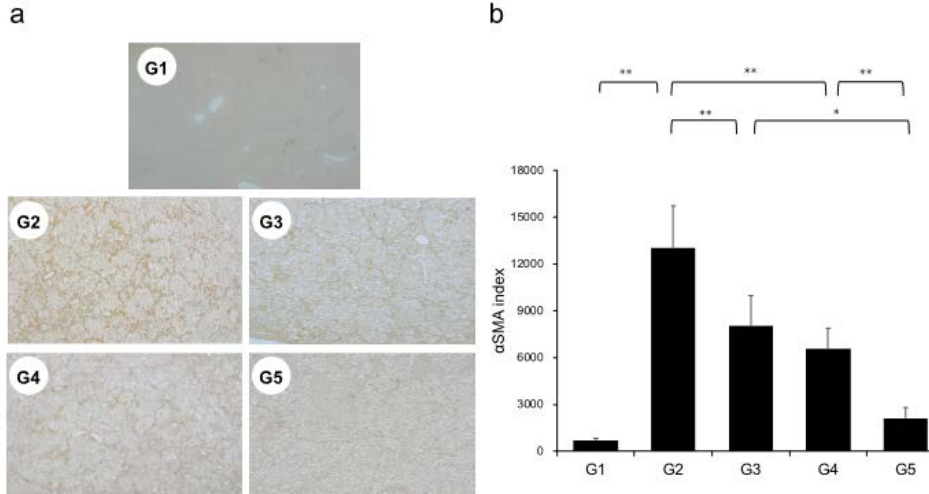
Figure 2. ( a ) Immunohistochemical analysis of alpha-smooth muscle actin ( α -SMA) expression. ( b ) α -SMA immunohistochemical staining is assessed using image analysis software. G1, Group 1 (choline-su ffi cient, L-amino acid-defined diet); G2, Group 2 (choline-deficient, L-amino acid-defined diet (CDAA)); G3, Group 3 (CDAA + canagliflozin (CA)); G4, Group 4 (CDAA + teneligliptin (TE)); G5, Group 5 (CDAA + CA + TE); Values represent mean ± SD ( n = 10). * p < 0.05, ** p <